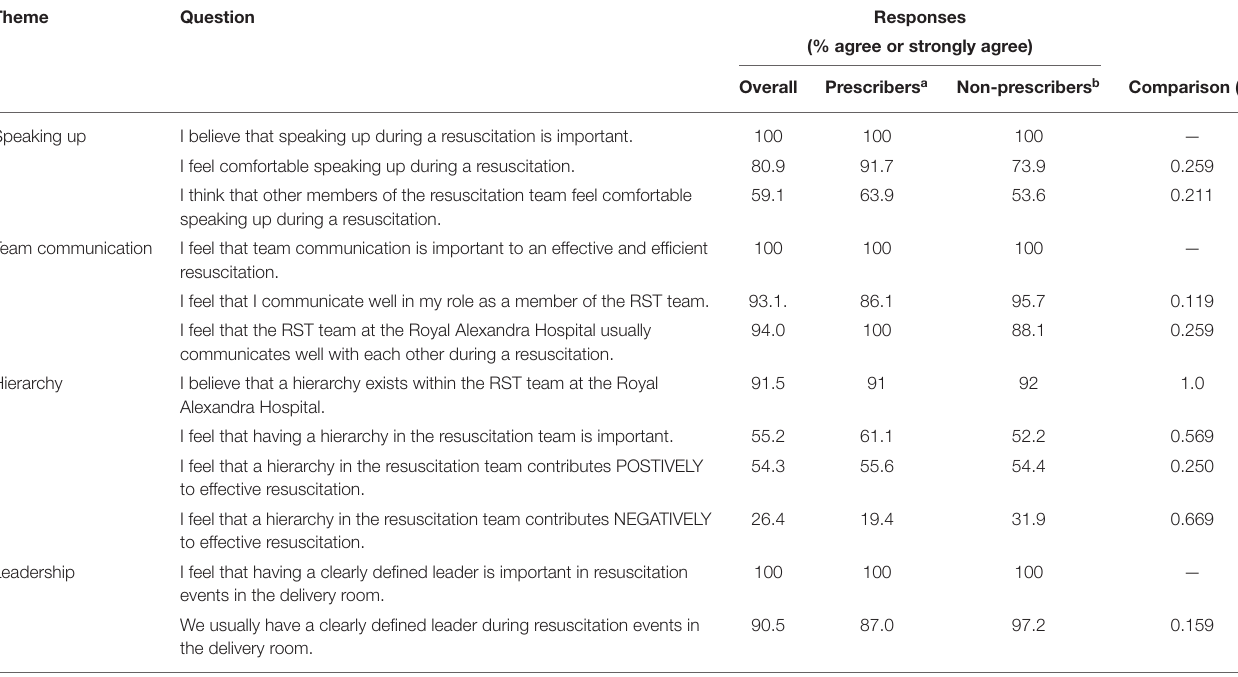
TABLE 2 | Summary of survey